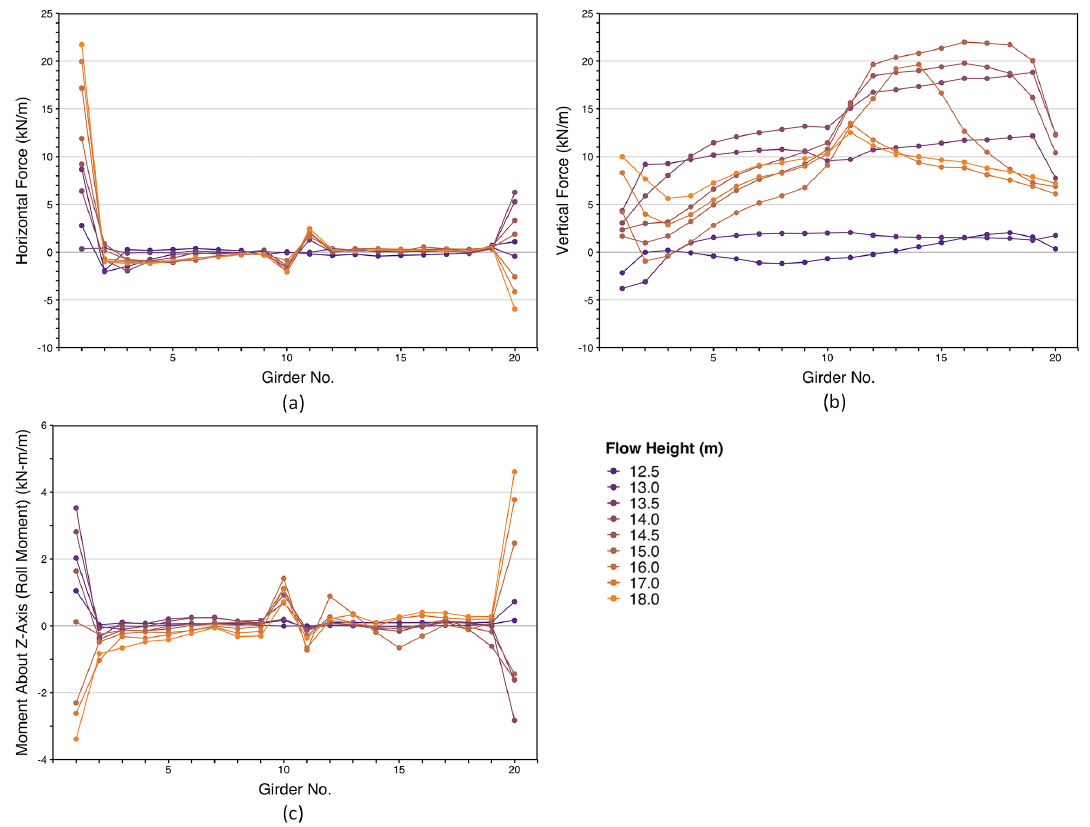
Figure 6. Converged simulated component loads for flow velocity equals 3ms − 1 per girder component; (a) shows horizontal ( x -direction) loads applied in kN per meter bridge width; (b) shows vertical ( y -direction) loads applied in kN per meter bridge width; (c) shows moment for the z -axis (i.e., roll moment) in kN per meter bridge